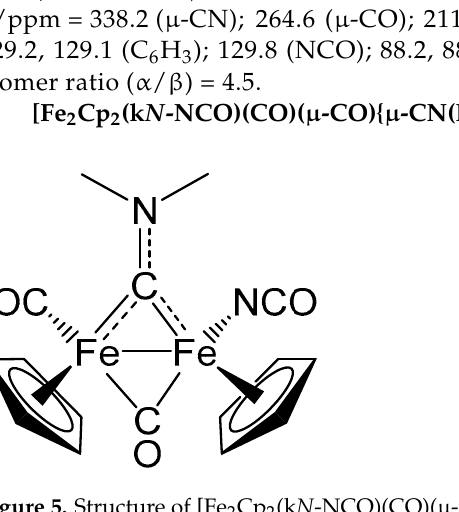
Figure 5. Structure of [Fe 2 Cp 2 (k N- NCO)(CO)(µ-CO){µ-CN(Me)(Me)}], 2b [39].